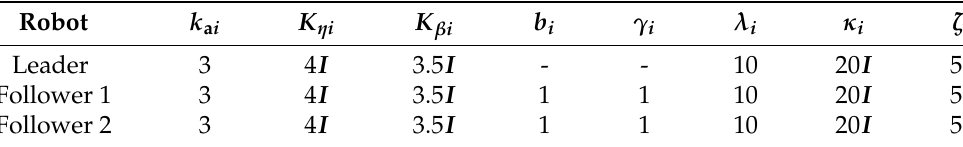
Figure 2. Experimental testbed: ( a ) Differential drive Khepera III mobile robot, and ( b ) Optitrack infrared camera. Table 1. Observer, controller gains and delay